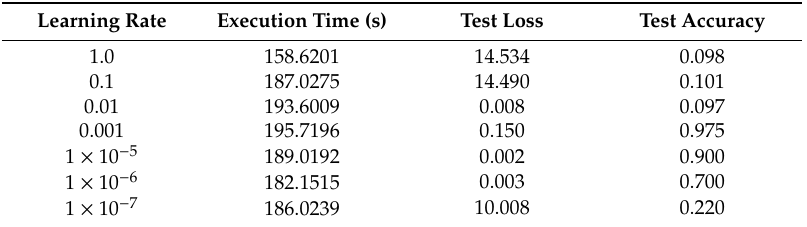
Table 8. E ff ect of learning rate on CNN.